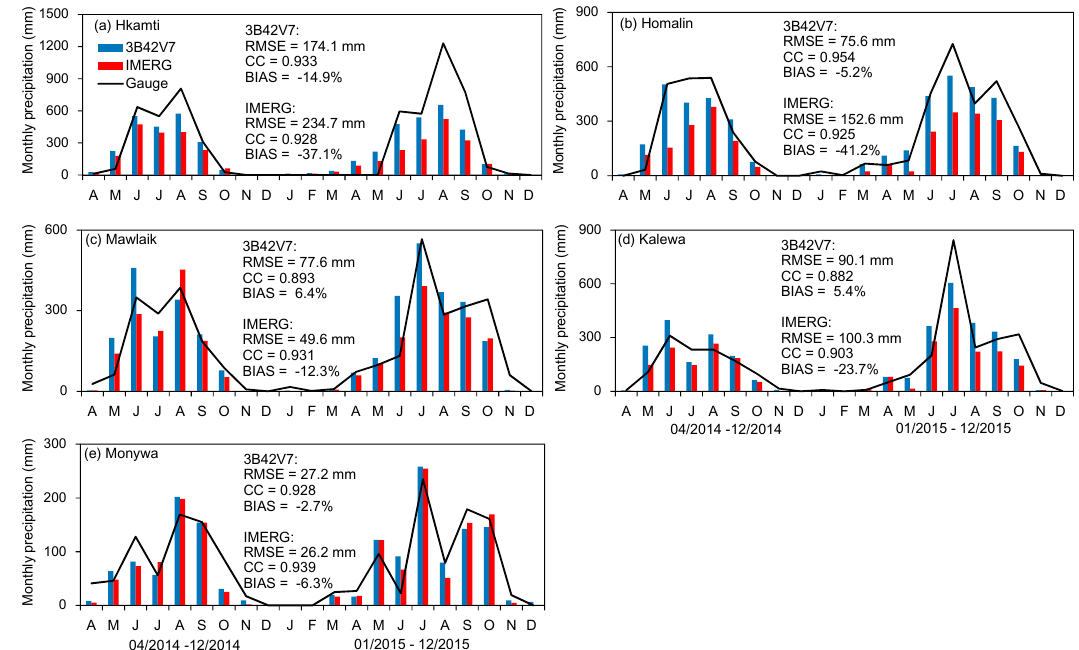
Figure 7. Monthly precipitation estimates from 3B42V7 and IMERG satellite precipitation products at the main weather stations against the gauge-based monthly precipitation time series from April 2014 to December